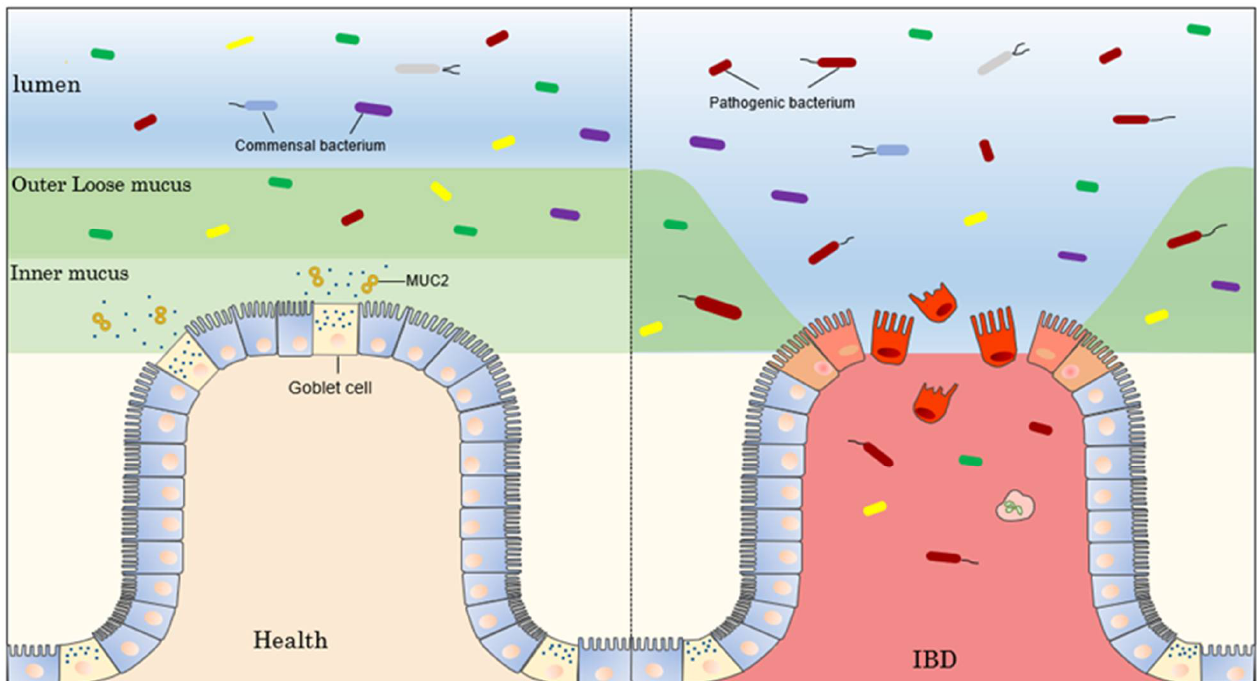
Figure 4. The colon has a two-layered mucus system; the outer layer is infiltrated by intestinal bacteria, and the inner layer is unaffected by bacteria and physically separates them from the epithelium. The lack of defects in this inner MUC2 mucin, which is the main mucus component of the intestine, disrupts the protective properties of the inner colonic mucus layer, allowing direct contact between bacteria and epithelial cells to cause inflammation and bleeding.